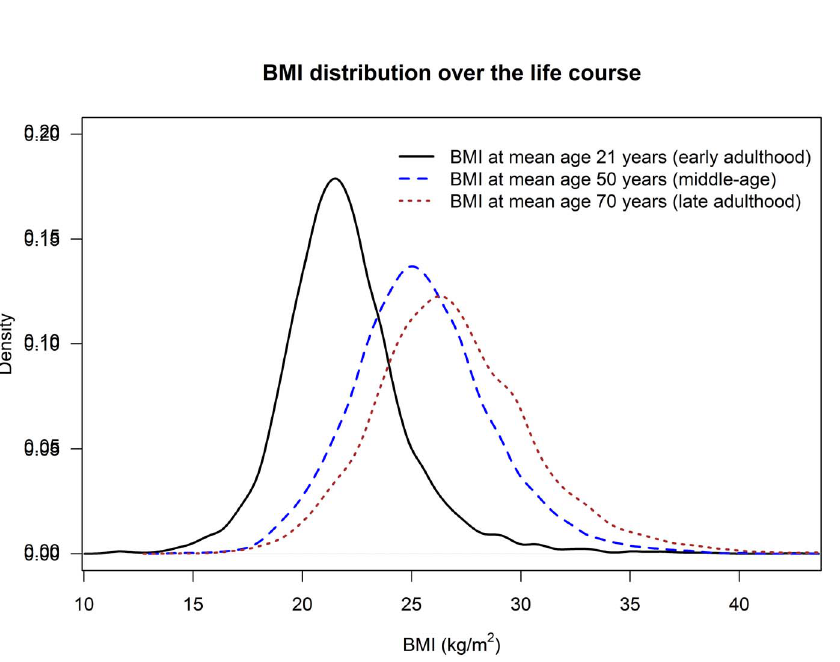
Figure 2. Mean BMI at mean age 21, 50 and 70 years, stratified by quintile of BMI distribution at age 21 (quintiles formed by using all available data at age 21; lines from bottom to top correspond to 1 st , 2 nd , 3 rd , 4 th , and 5 th quintiles, respectively). Note: Individuals may be moving across